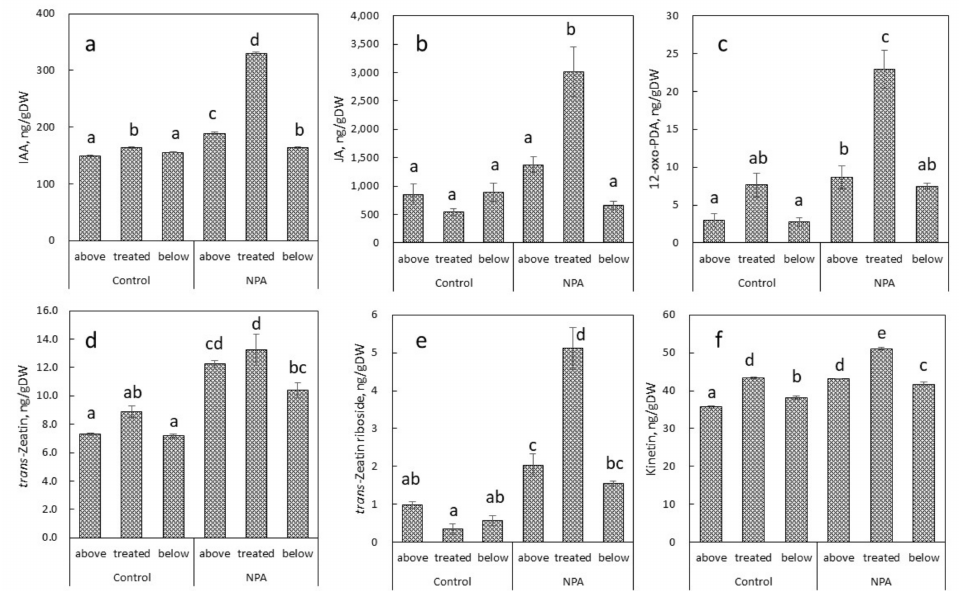
Figure 3. Effect of NPA (0.4%, w/w in lanolin) on endogenous levels of IAA ( a ), jasmonic acid (JA) ( b ), 12-oxo-phytodienoic acid (12-oxo-PDA) ( c ), trans -zeatin ( d ), trans -zeatin riboside ( e ), and kinetin ( f ) in 4–5-mm pieces of internode at the NPA treatment site, and areas above and below in B. calycinum. Treated, above and below in the figure indicate plant hormone levels at, above and below areas of the treatment, respectively. Values are means with standard errors ( n = 3). Different letters indicate statistical differences in Duncan’s multiple range test at p < 0.05 after analysis of variance (ANOVA). Table 1. Effect of NPA (0.4%, w/w ) on endogenous levels of abscisic acid, salicylic acid, cis -zeatin, cis -zeatin riboside, and gibberellins determined in 4–5-mm stem pieces treated with or without NPA in B. calycinum. Above and below in the table indicate plant hormone levels in the above and the below areas of the treatment, respectively. Values are the means with standard errors ( n = 3). Different letters indicate a statistical difference in Duncan’s multiple range test at p < 0.05 after ANOVA. Plant Hormone, Control (Lanolin) NPA Treatment ng/gDW Above Treated Area Below Above Treated Area Below Abscisic